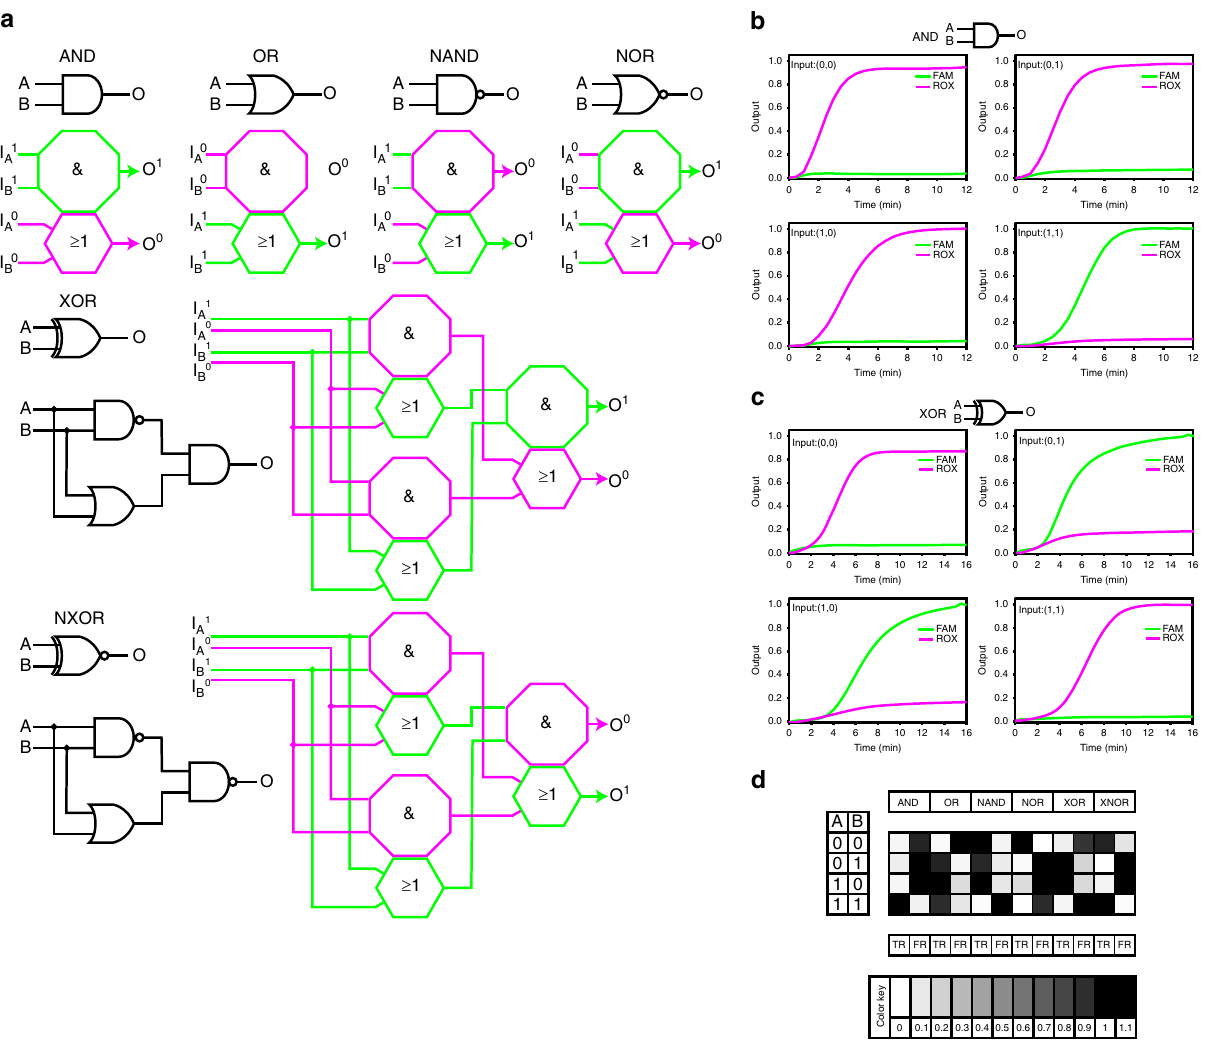
Fig. 2 Construction of six basic dual-rail systems and their performance. a Construction of the AND, OR, NAND, NOR, XOR, and XNOR dual-rail gates. The upper regular octagon shows a single-rail AND gate, and the lower regular hexagon shows a single-rail OR gate. The green and magenta colors mean de fi ned TRUE and FALSE signals, respectively. Superscripts 1 and 0 also indicate the TRUE and FALSE inputs and outputs, respectively. When computations were performed, a set of input strands must be adder, e.g., inputs (1, 0) means adding inputs I A 1 (TURE) and I B 0 (FALSE). Detailed structures can be seen in Fig. S12. Reaction details of AND and XOR gates can be seen in Supplementary Figs. 7 and 8. b , c Reaction kinetics of the dual-rail AND and XOR gates with all possible combinations of inputs. The reaction was performed with 3.2 U Bst polymerase (large fragment), TRI and FRI at 35 °C. The curve was plotted by transferring the cycle value into the reaction time. The outputs were normalized to the RFU values in the FAM and ROX channels with the highest signals. The FAM and ROX signals correspond to the TRUE and FALSE returns, respectively. Sequences of the DNA strands are listed in the Supplementary Information. d Summary of all the outputs computed by the six basic logic gates constructed from